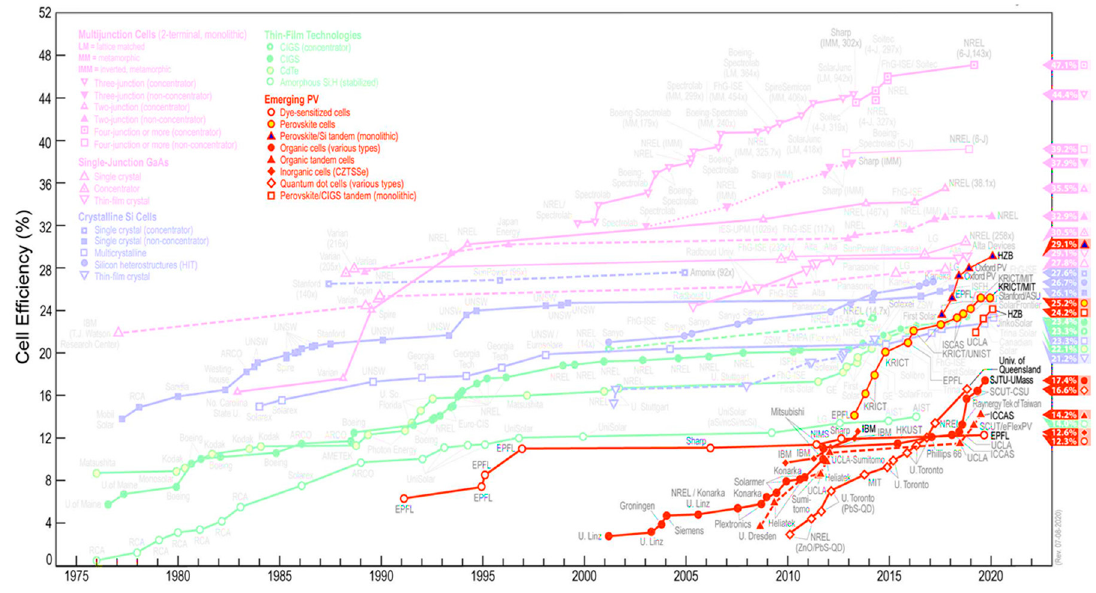
Figure 5. Summary of the reported solar cell efficiencies with various types of photovoltaic cells from 1991–2020 [180]. This plot is courtesy of the National Renewable Energy Laboratory, Golden, CO.